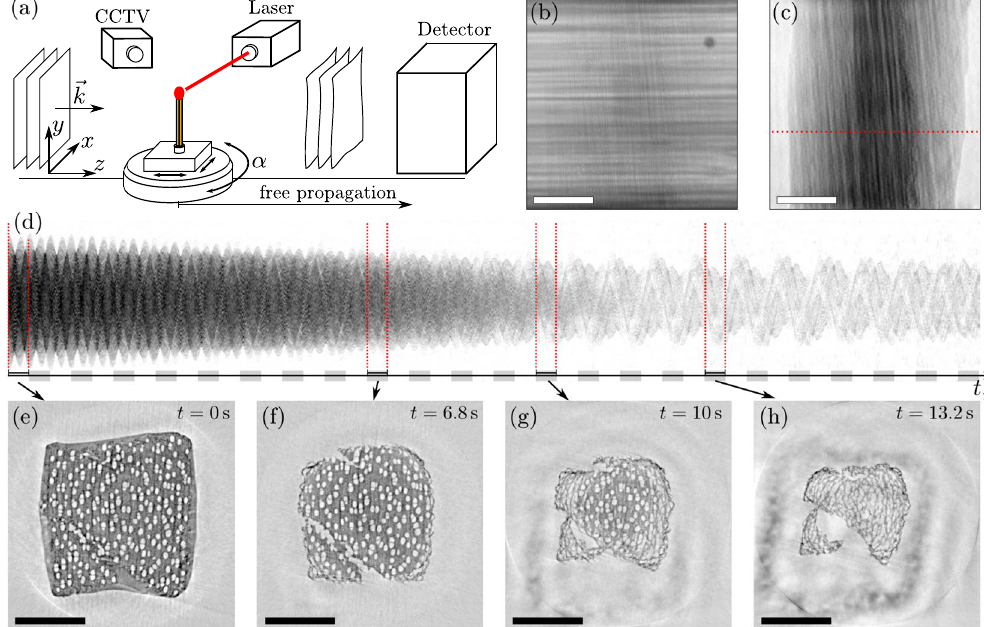
Figure 3. Illustration of the experiment. ( a ) Setup of the TOMCAT beamline with parallel beam illumination of the match positioned at the center of a fast rotating stage. The match was ignited by a laser system and observed by a CCTV camera. The detection system was positioned 228 mm behind the object. ( b ) A raw image recorded with an acquisition time of 1 ms, and ( c ) the same image after preprocessing and phase-retrieval (see text). ( d ) A sinogram extracted from all 18800 reconstructed projections at the position of the red dashed line. A shrinking of the structure and a loss of material is observed, accompanied by a decrease in photon absorption. The bottom row depicts tomographic reconstructions of the highlighted sinogram segments, each consisting of 401 equidistant projections. The shape, features of the wooden structure and the stages of the burning process can be clearly identified. Nevertheless, the reconstructions show motion artefacts such as ‘streaks’ and non-closed shapes in detail. Scalebars 1